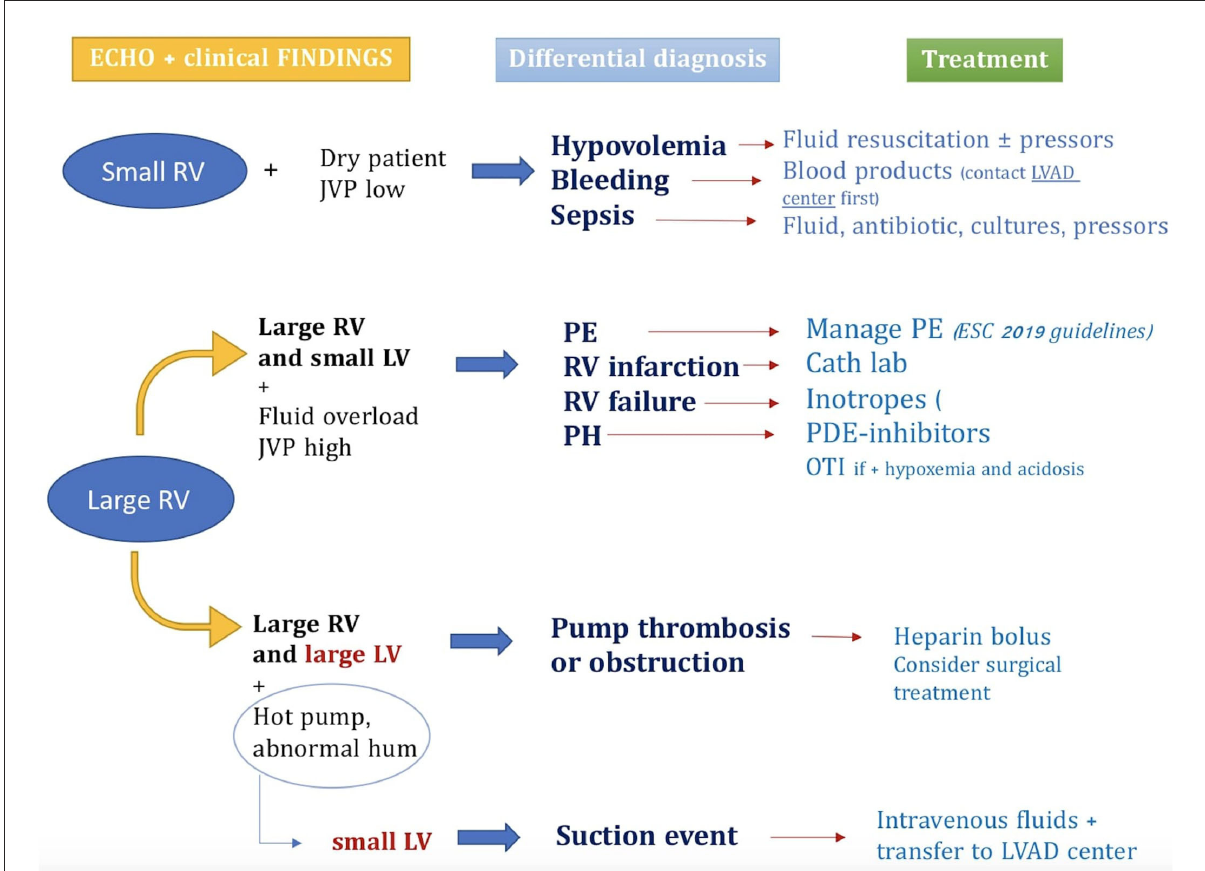
FIGURE2 An algorithm for the differential diagnosis and treatment of LVAD emergencies that represent an important added value of performing bedside echocardiography. JVP, jugular venous pressure; LV, left ventricle; LVAD, left ventricle assist device; OTI, intubation orotracheal; PDE, phosphodiesterase; PE, pulmonary embolism; PH, pulmonary hypertension; RV right